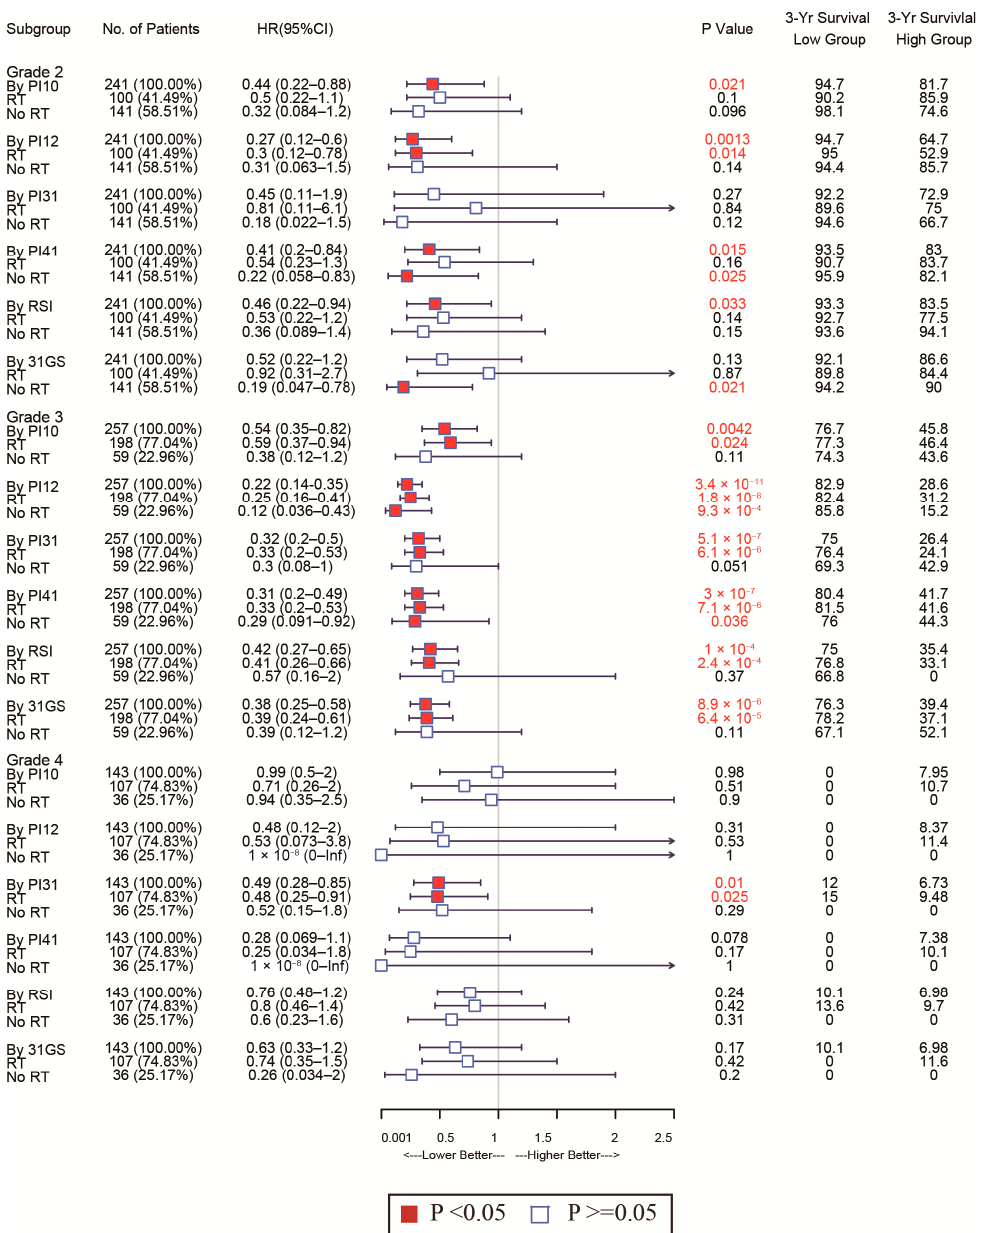
Figure 7. Forest plots to test the specificity of the selected markers for different WHO stages in the CGGA cohort.